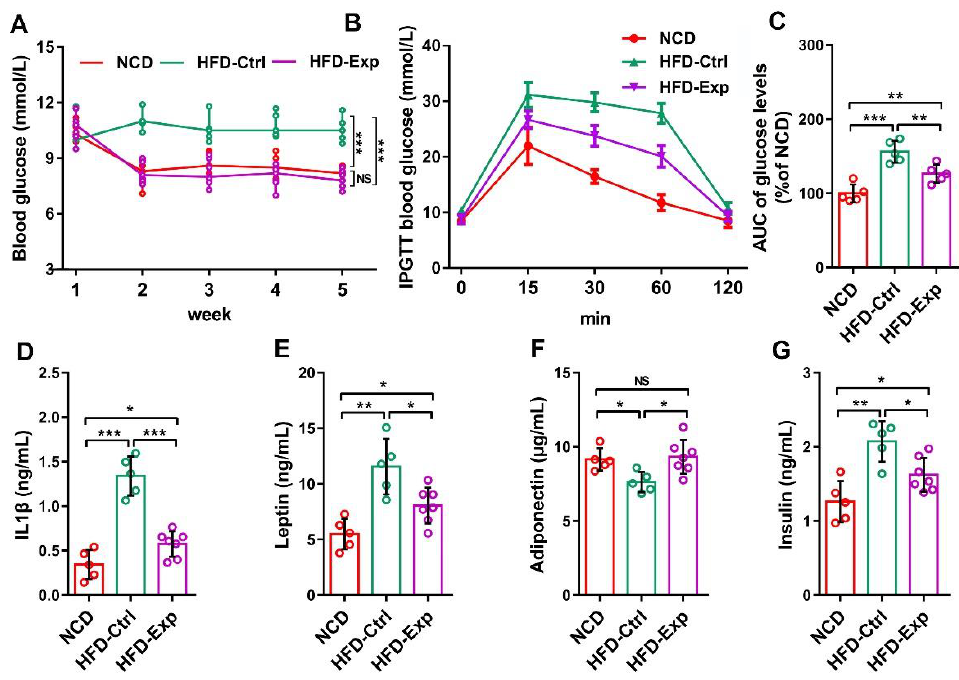
Figure 5. IL-1 β shRNA/yeast regulated blood glucose concentration and cytokines expression in serum. ( A ) Changes of blood glucose concentration. ( B ) Glucose tolerance test. ( C ) Area under curve (AUC) of glucose levels after intraperitoneal injection of glucose. ( D – G ) The expression of IL-1 β , leptin, adiponectin and insulin in the serum. NS (no significance). * p < 0.05, ** p < 0.01, *** p < 0.001 ( n = 5 or 7).